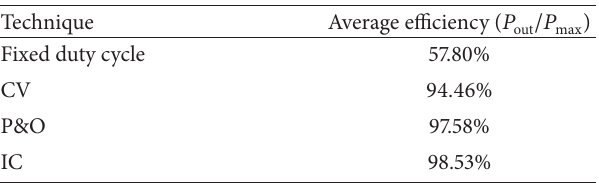
Figure 9: Detailed view of 𝑃